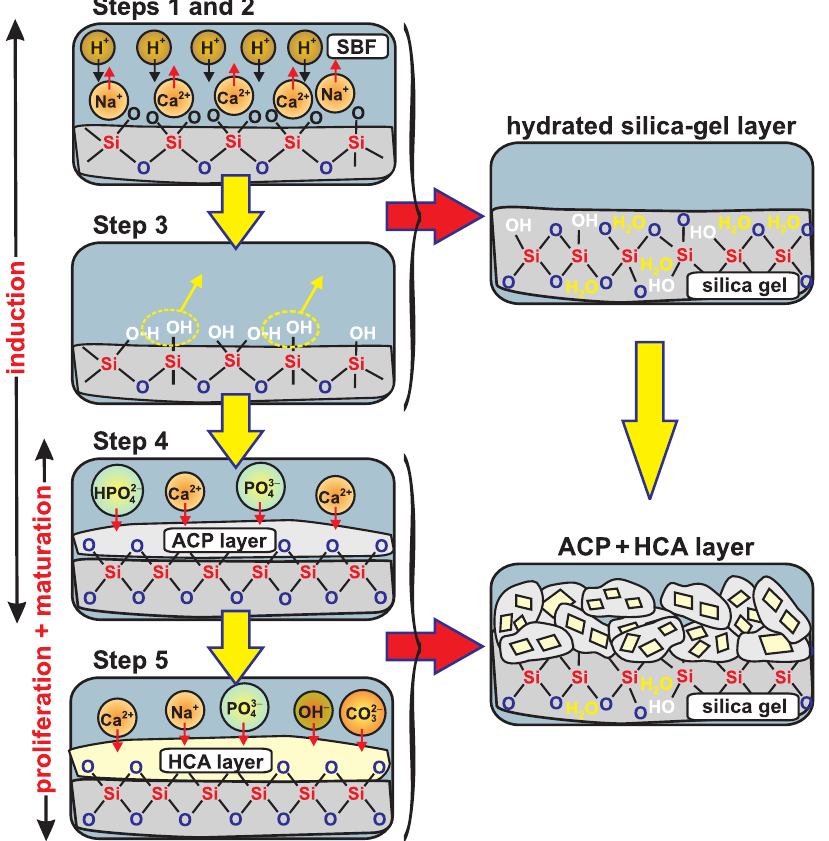
Figure 4. Schematic illustration of the Hench mechanism [2] for HCA formation from a melt-prepared Na–(Ca)–Si–O–(P) glass exposed to SBF; the five HM stages are identified with the induction, proliferation, and maturation stages associated with sigmoidal growth (arrows; left panel). The first three HM steps involve (1) exchange of Na + /Ca 2 + cations with protons from the solution, and (2) hydrolysis of Si–O–Si bonds, together leading to a high abundance of silanol (SiOH) surface groups, a portion of which (3) form Si–O–Si linkages by water removal. As depicted in the right panel, the HM stages (1)–(3) together produce a silica-gel layer, which comprises SiOH groups and water, but is nearly devoid of Na + /Ca 2 + species. Next follows (4) a heterogenous nucleation of ACP, which then (5) crystallizes into HCA. The two last HM steps proceeds in parallel, with co-existing ACP/HCA components of the CaP layer ( bottom , right ), where HCA crystallizes from the interior of the ACP particles